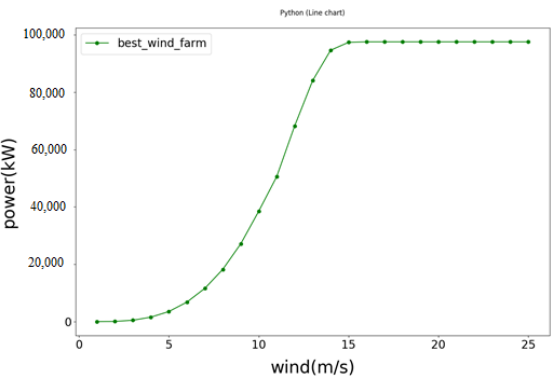
Figure 10. Wind velocity-dependent power output of the optimized windfarm.